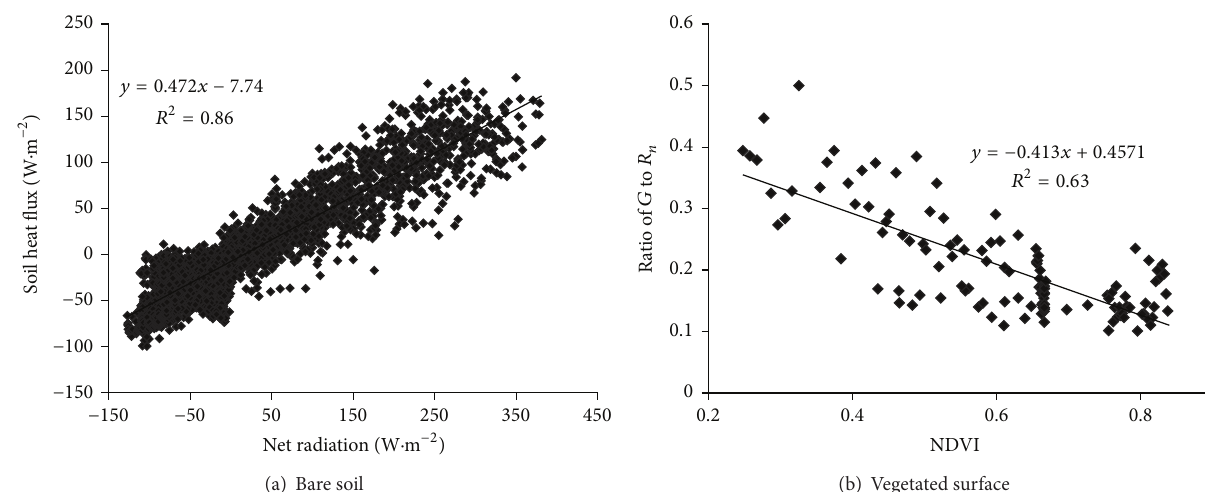
Figure 1: The linear relationship between the ratio of 𝐺 to Rn and NDVI at YC Station in 2003.